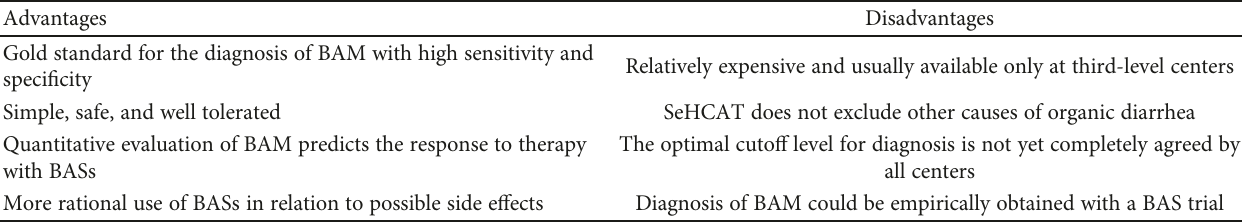
Table 1: Advantages and disadvantages of the SeHCAT test for